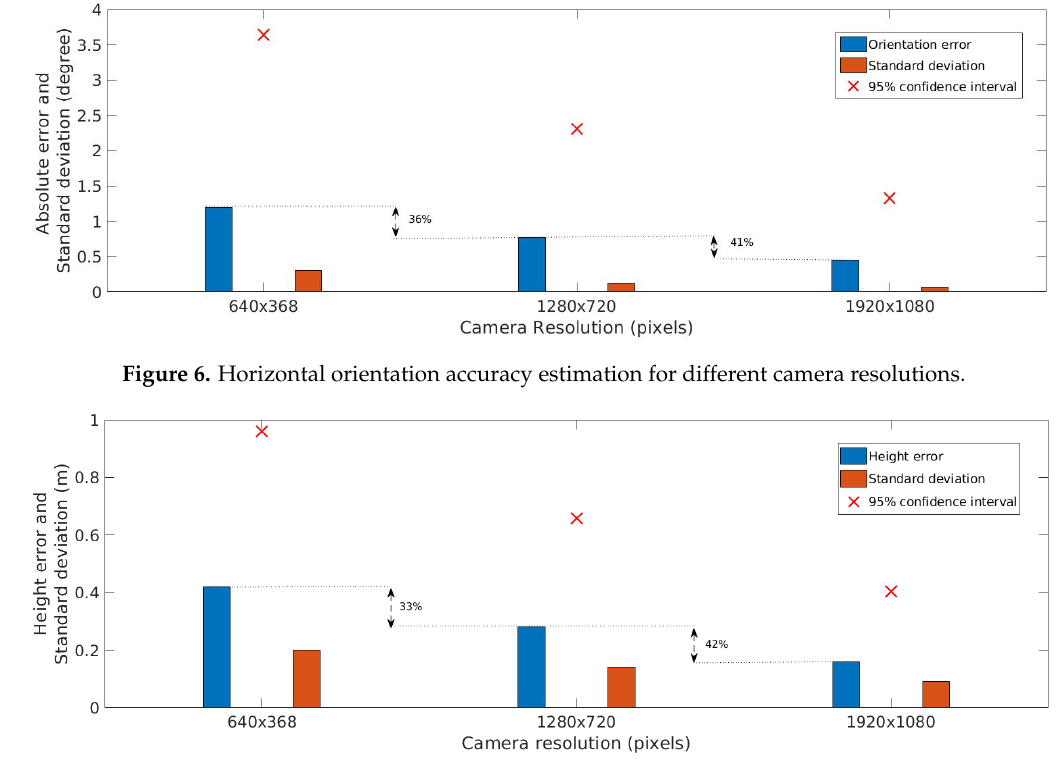
Figure 7. Height accuracy estimation for different camera